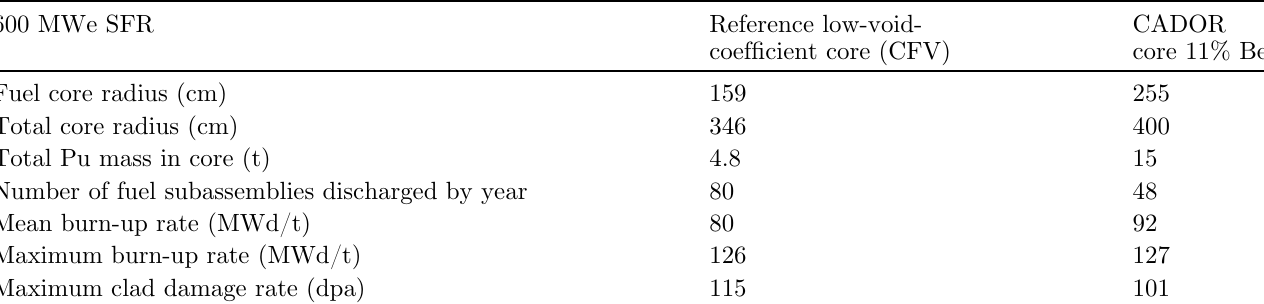
Table 5. Comparison of the CADOR and CFV core